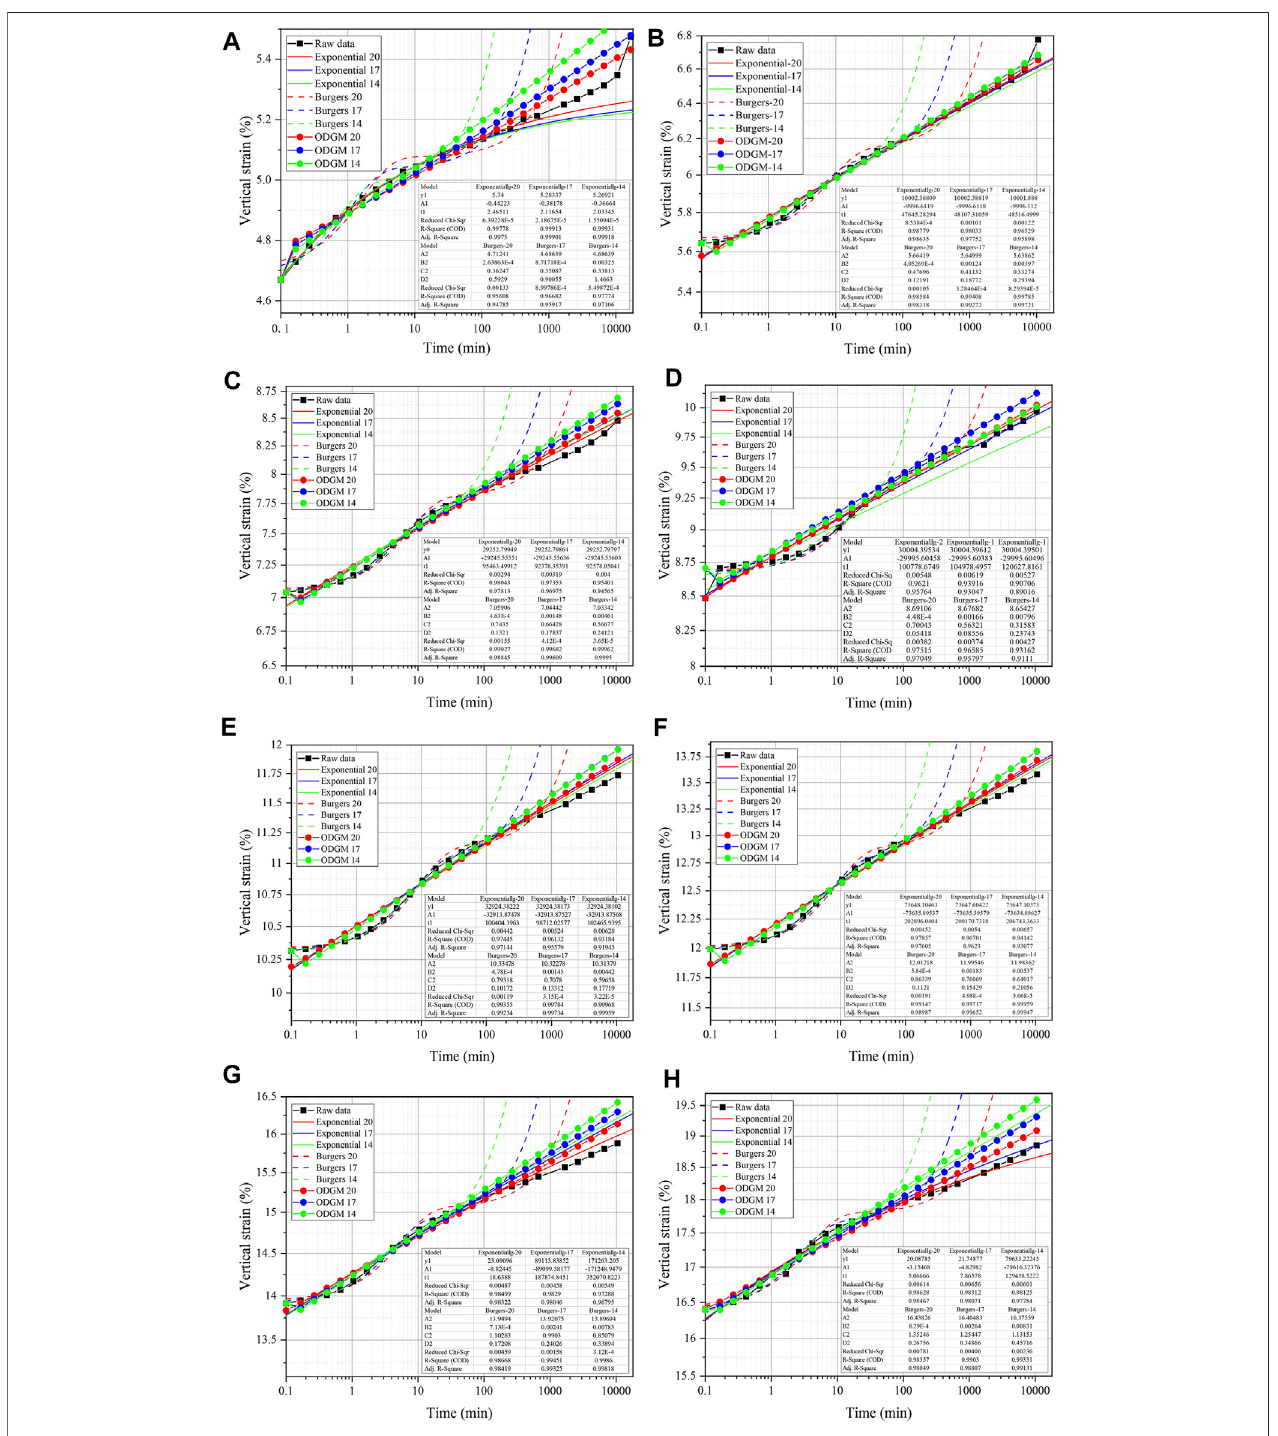
FIGURE 10 | Relationship of vertical strain and time (log-scale) and prediction results of three models under different vertical stresses (20 data points/17 data points/14 data points). (textbf (A) σ =25 kPa, textbf (B) σ =50 kPa, textbf (C) σ =100 kPa, textbf (D) σ =200 kPa, textbf (E) σ =400 kPa, textbf (F) σ =800 kPa, textbf (G) σ =1600 kPa, textbf (H) σ =3,200 kPa).